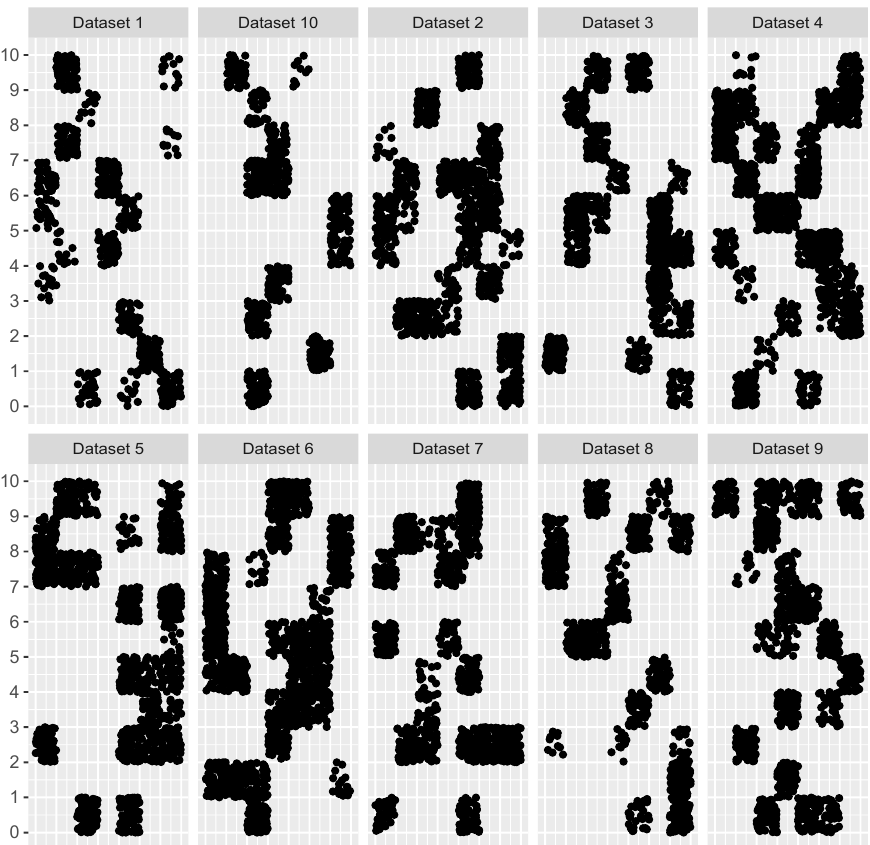
Figure 2. Simulated datasets for the first